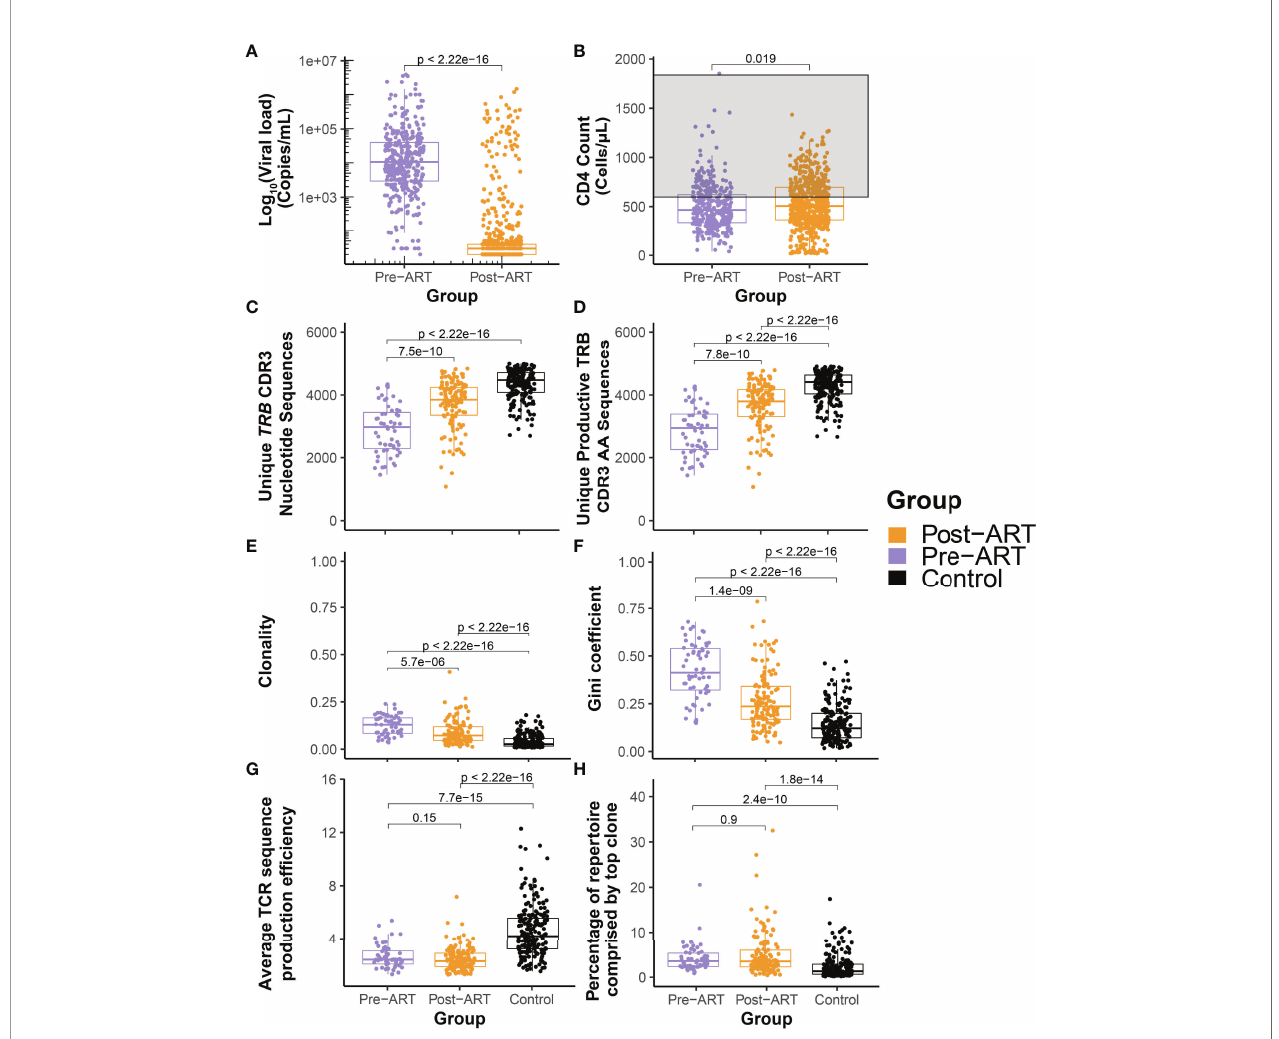
FIGURE 2 | Durable suppression of HIV with ART is characterized by signi fi cant diversi fi cation of the T-cell b -chain repertoire but persistence of large clonal expansions and perturbed architecture. Pooled distributions of all log 10 HIV viral load (A) and CD4 + T-cell count (B) measurements obtained from the cohort of 30 PLHIV up to 12 years before (purple) and after (orange) initiation of ART. The grey region in (B) indicates the generally accepted normal range of the peripheral blood CD4 + T-cell count. (C) Total number of unique TRB CDR3 nucleotide sequences and (D) number of unique productive TRB CDR3 amino acid sequences in 59 TRB repertoires assessed before (purple) and 129 repertoires assessed after (orange) initiation of ART in the cohort of 30 PLHIV, and from 189 control bone marrow transplant donors each evaluated at a single time point. (E) Clonality of the pre- and post-ART PLHIV repertoires and of the control repertoires. (F) Equality of the TRB CDR3 amino acid sequence distributions in the pre-ART, post-ART, and control repertoires as captured by the Gini coef fi cient. (G) Mean TRB sequence production ef fi ciency. (H) Percentage of total repertoire sequence count contributed by the most frequent TRB CDR3 amino acid